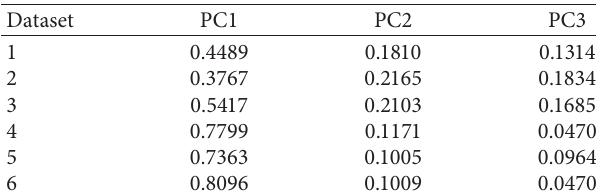
Table 5: Proportion of variance of the first three principal com- ponents for each